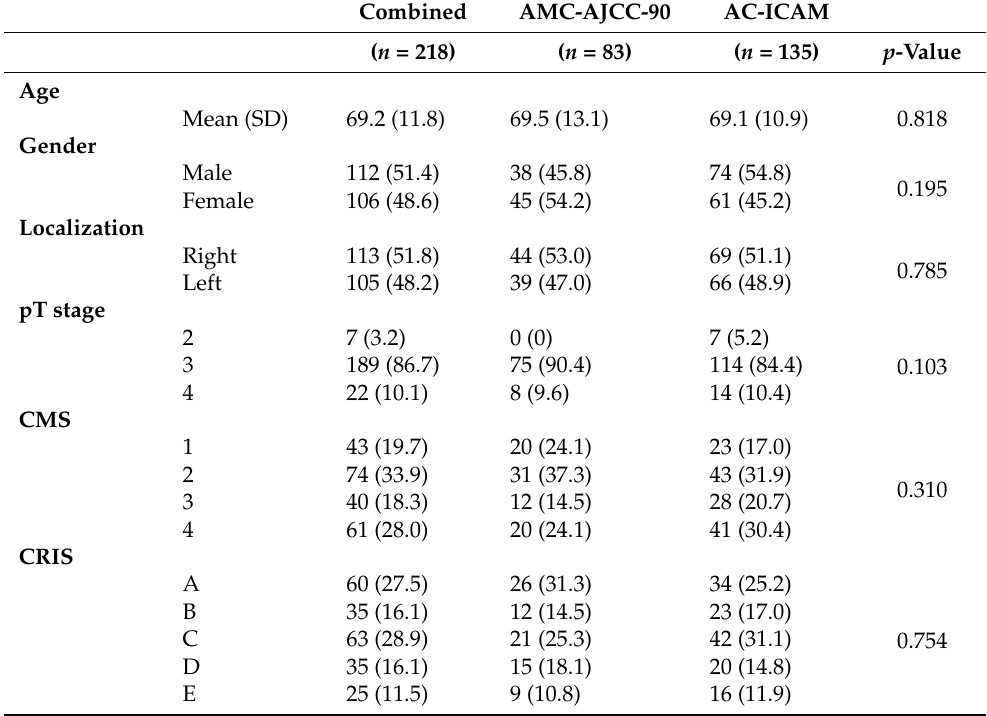
Table 1. Baseline characteristics of the included cohorts. Age is depicted as mean with standard deviation, other characteristics as absolute number and percentage. p -values are derived from comparison between the AMC-AJCC-90 and AC-ICAM